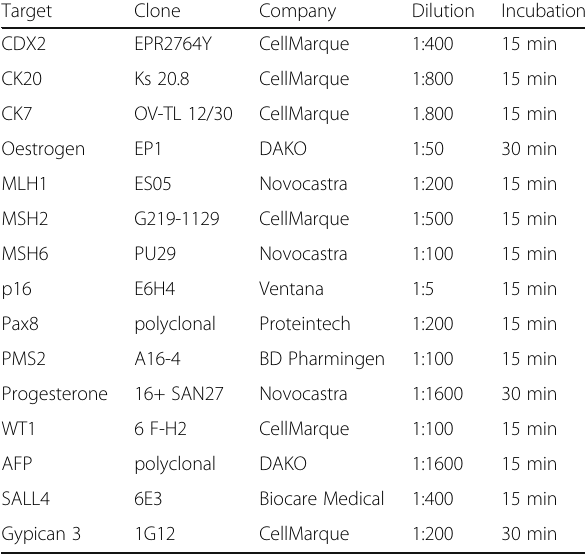
Table 1 Antibodies used for immunohistochemistry